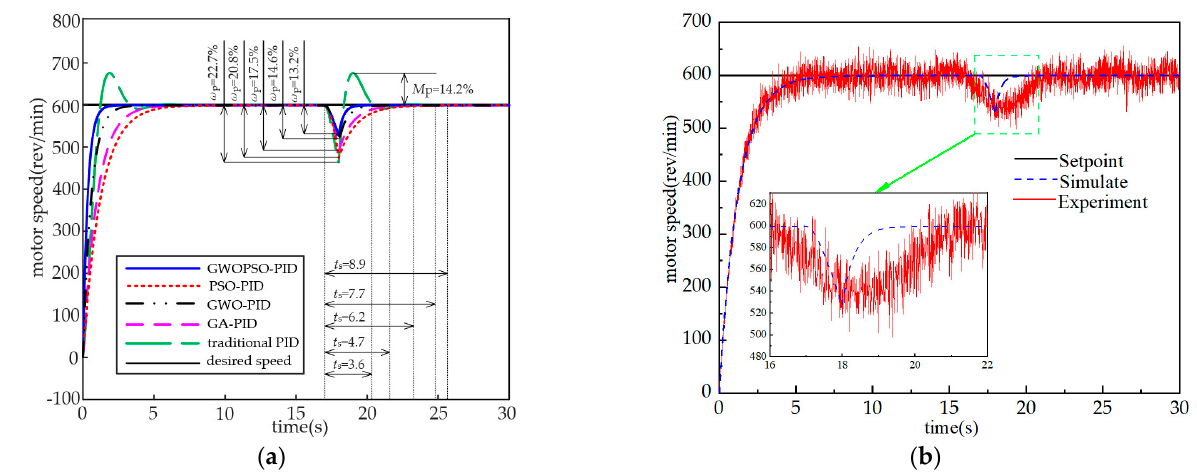
Figure 10. Slow-varying load response of the PMSS. ( a ) Simulation results; ( b ) experimental results.